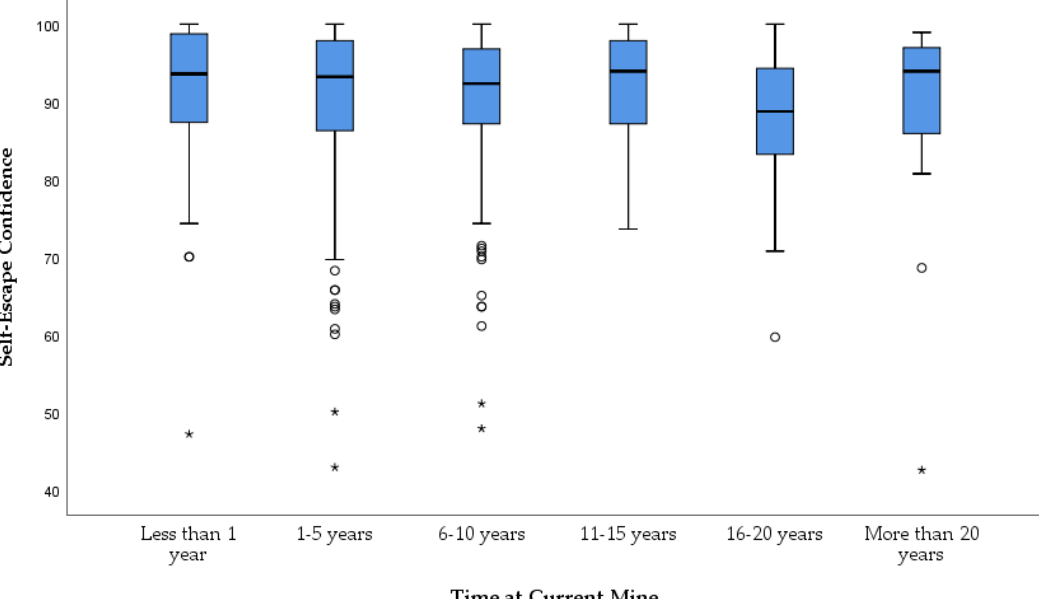
Figure 1. A box plot depicting the distribution of average confidence of hourly workers across 28 self-escape competency items (on a 100-point confidence scale) based on time at current mine. The circles are outliers and the asterisks are extreme outliers. About 95% of the data falls between the inner fences (i.e., the t-bars that extend from the boxes).